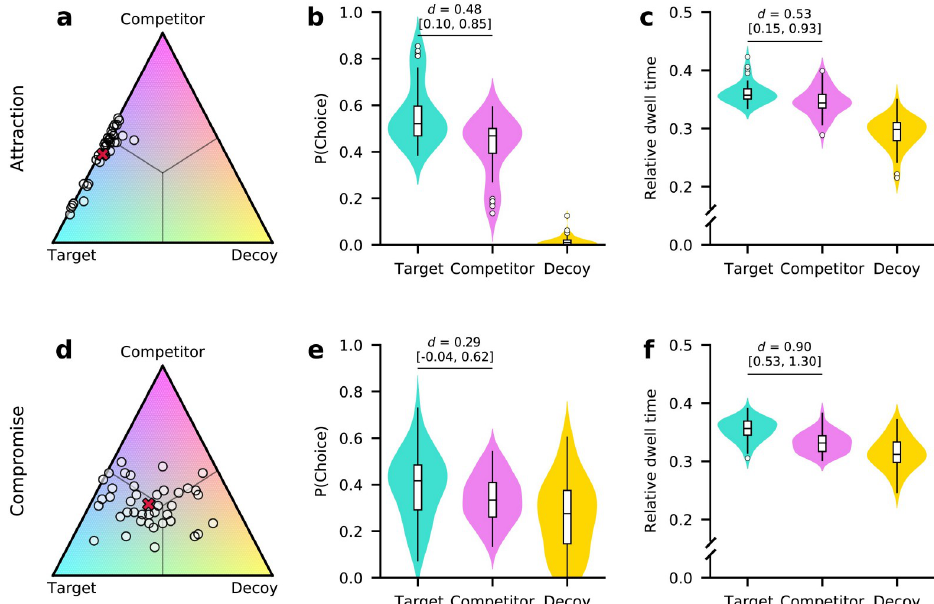
Fig 2. Context effects are present in choices and relative dwell time. Participants’ choices were influenced by asymmetrically dominated decoys and, to a lesser extent, by extreme compromise-making decoys. (a, d) Ternary plots of individual relative choice frequencies for target (lower left, teal), competitor (top, pink), and decoy (lower right, yellow) alternatives in attraction (a) and compromise (d) trials. Each dot represents one participant. The position on the simplex indicates relative choice frequencies for alternatives. Straight lines from the centre indicate equal frequencies for two alternatives. The red "x" indicates the group average. (b, e) Relative choice frequencies in attraction (b) and compromise (e) trials. In attraction trials, some participants strongly favoured the target alternative and almost no decoy choices were made. While target alternatives are still chosen more frequently than competitors in compromise trials, the effect is less pronounced, and extreme decoys are still chosen frequently. (c, f) Relative dwell time towards alternatives. In both, attraction (c) and compromise (f) trials, target alternatives received greater relative dwell times than competitors. d denotes Cohen’s d from paired BEST analysis with HDI 95 given in brackets. Violin plots show kernel density estimates of distributions of individual values. Box plots mark lower and upper quartiles and median. Whiskers extend from first and last datum within 1.5 times the interquartile range from lower and upper quartiles, respectively. Values outside this range are indicated by open